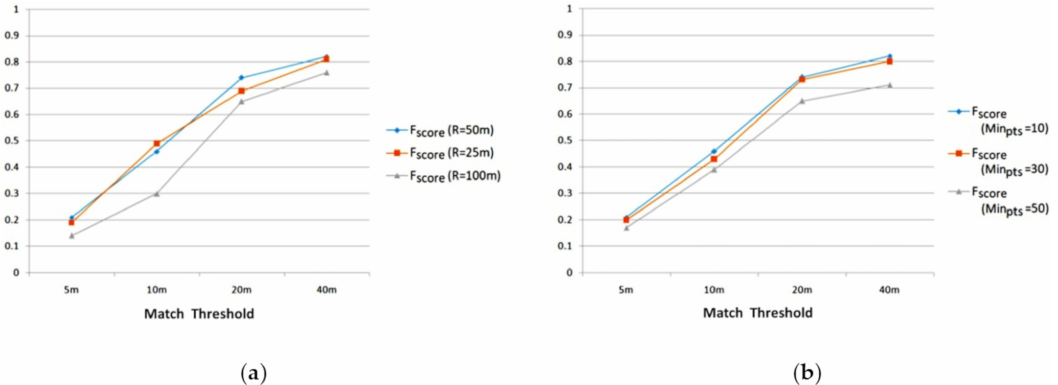
Figure 13. Detection F score with di ff erent cluster algorithm settings; ( a ) using di ff erent cluster radius thresholds; ( b ) using di ff erent cluster-points